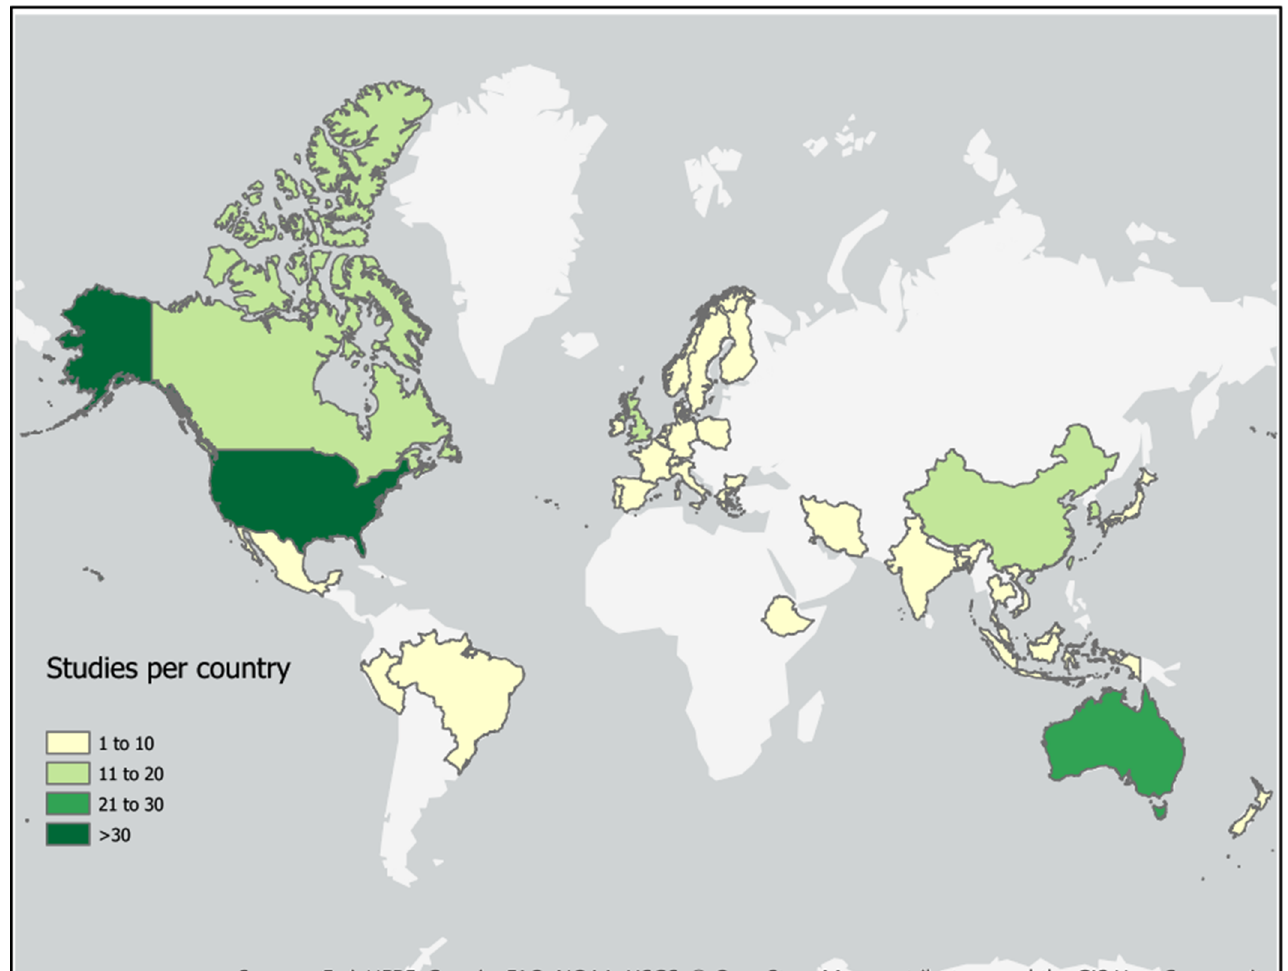
Figure 3. Study location by site of research. A single study may have sites in more than one location. This map does not include review papers.